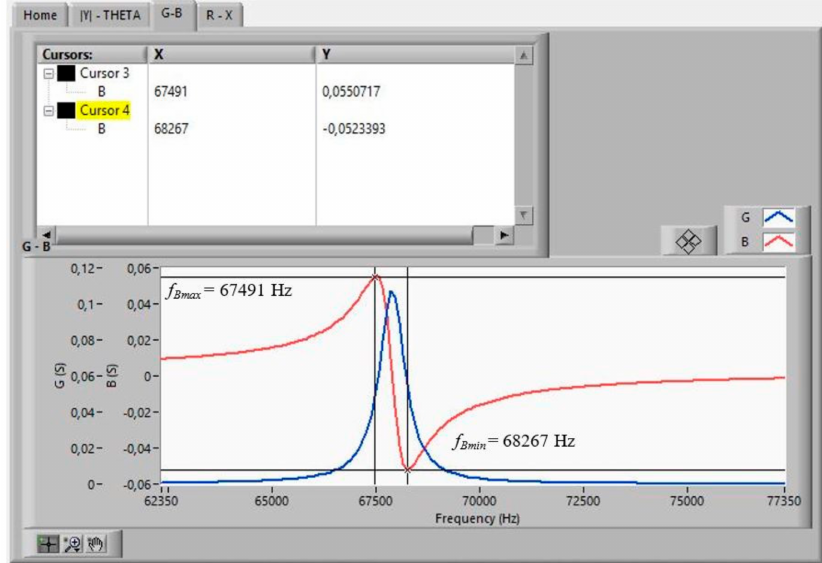
Figure 12. Searched frequencies after the automatic search step: f Bmax , f Bmin .